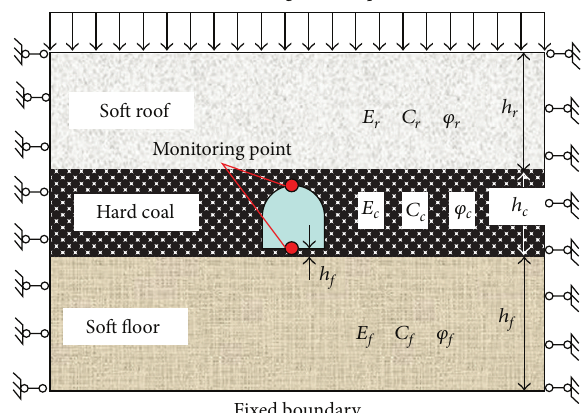
Figure 2: Compound physical model of soft rock and coal